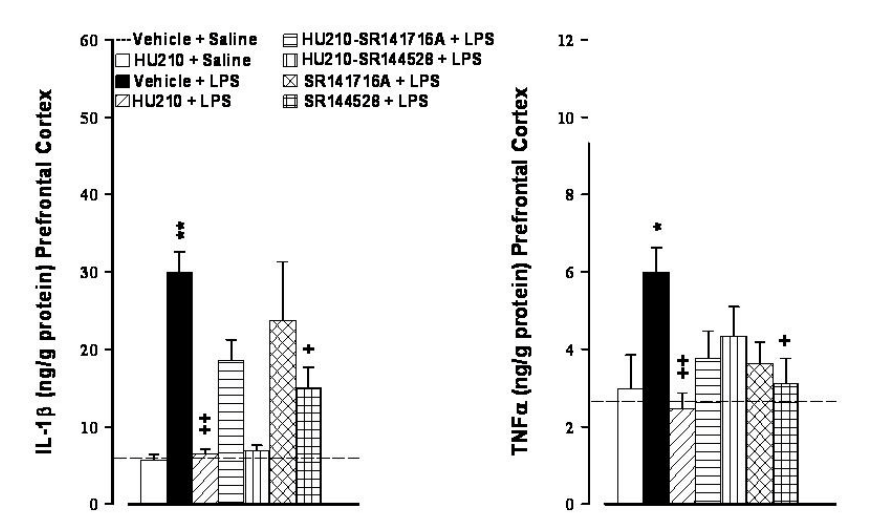
/CB receptor agonist HU210 (100 µg/kg i.p.) and CB Figure 1. The CB 1 2 antagonist SR144528 (3mg/kg i.p.) attenuated LPS (100 µg/kg i.p)-induced increases in IL-1β and TNFα levels in the prefrontal cortex in